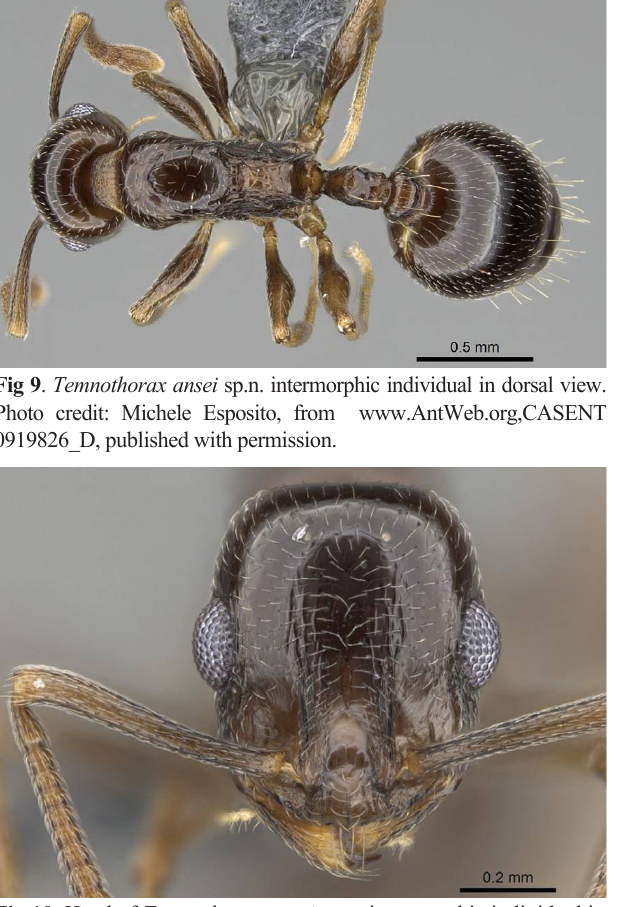
Fig 10 . Head of Temnothorax ansei sp.n. intermorphic individual in frontal view. Photo credit: Michele Esposito, from www.AntWeb. org, CASENT0919826_H, published with